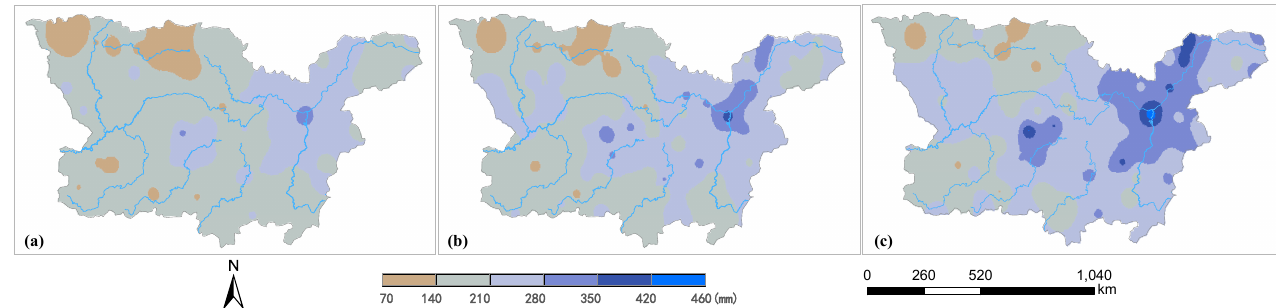
Figure 5. Daily precipitation extremes for different return periods: ( a ) 30 years; ( b ) 50 years; ( c ) 100 years.